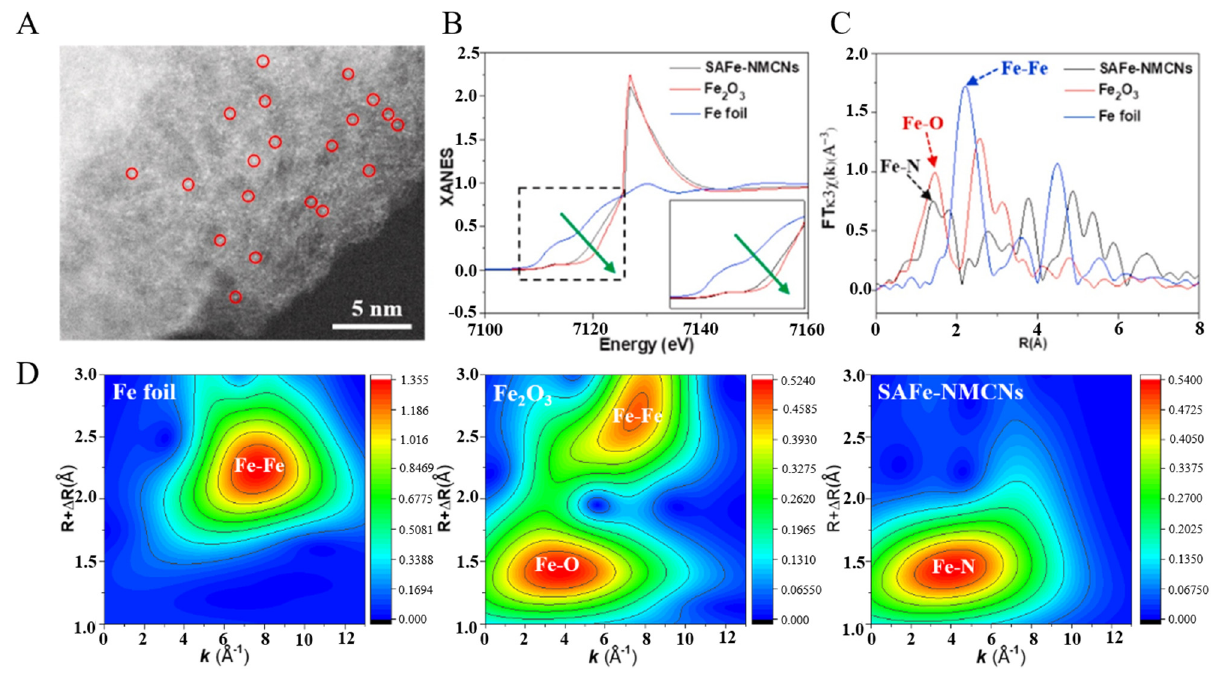
Figure 4. Structure characterization of SAFe-NMCNs ( A ) HAADF-STEM. ( B ) XANES. ( C ) FT-EXAFS. ( D ) WT-EXAFS [83]. Copyright 2022,